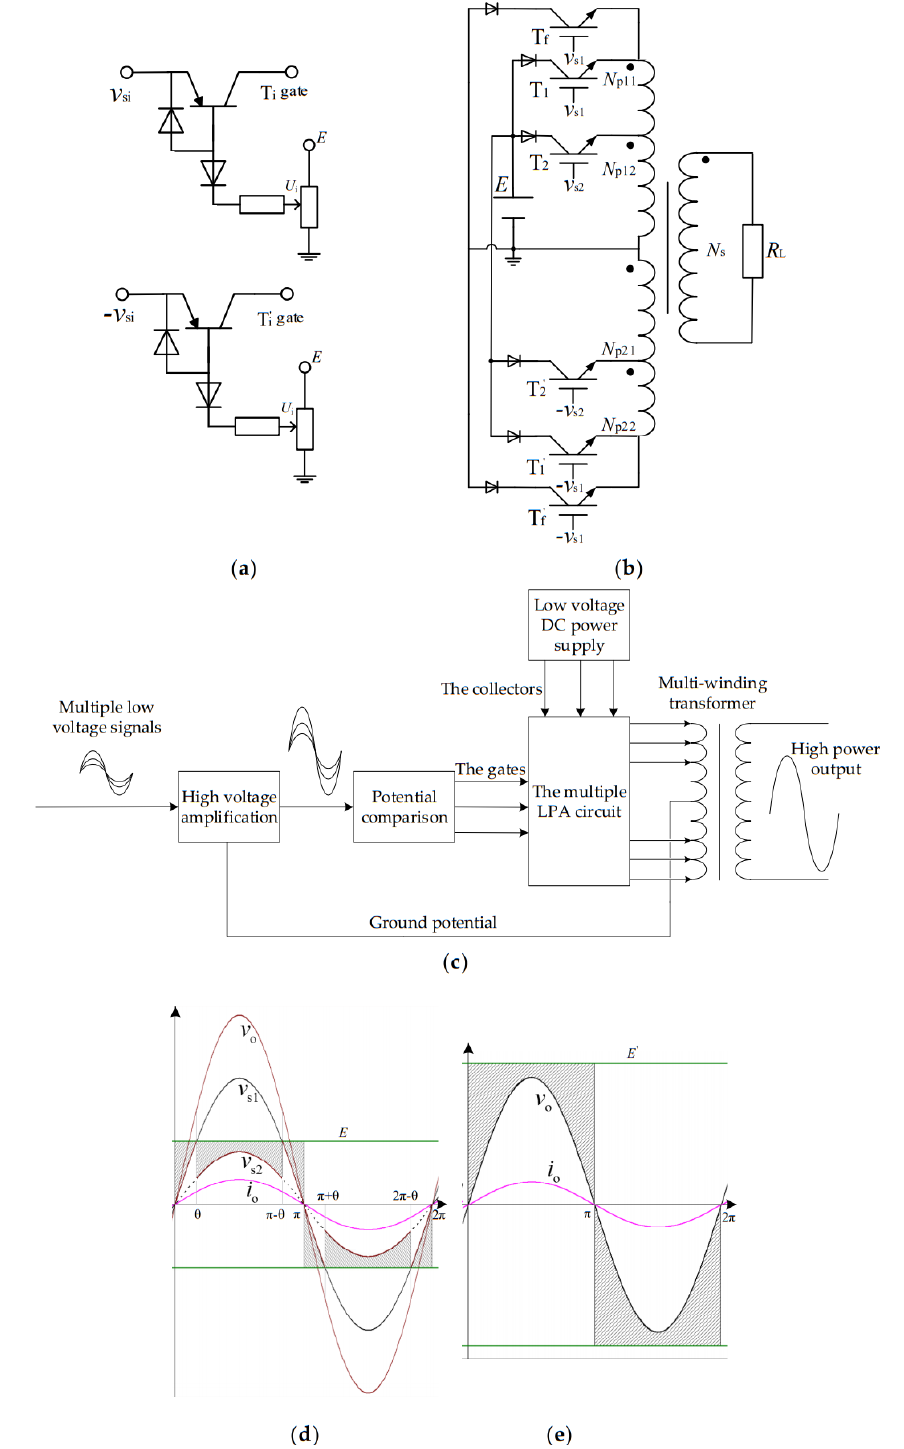
Figure 5. Operating principle of two-stage HDCPLN. ( a ) Control signal judgment circuit. ( b ) Main circuit topology. ( c ) Control structure diagram. ( d ) Work process. ( e ) Traditional amplifier work process.